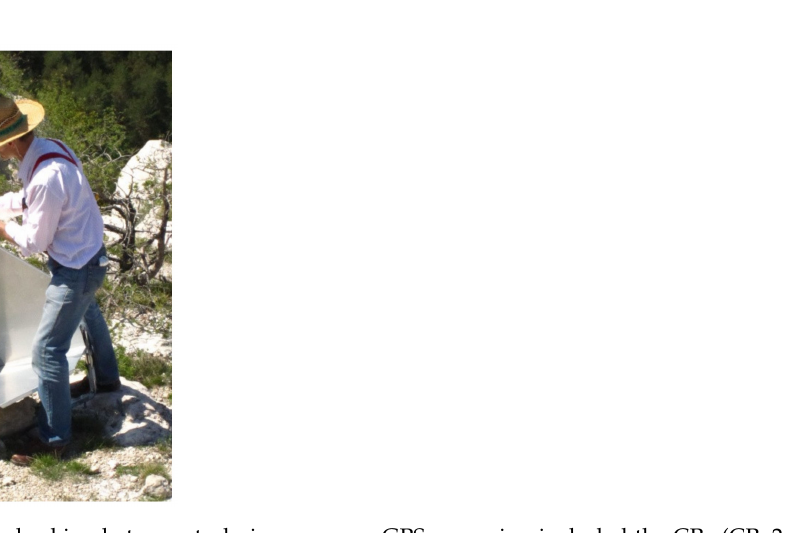
Figure 23. Cross-checking between techniques: every GPS campaign included the CRs (CR_2 in the picture) and the top of the boreholes where the wire extensometers and/or the inclinometers were installed.